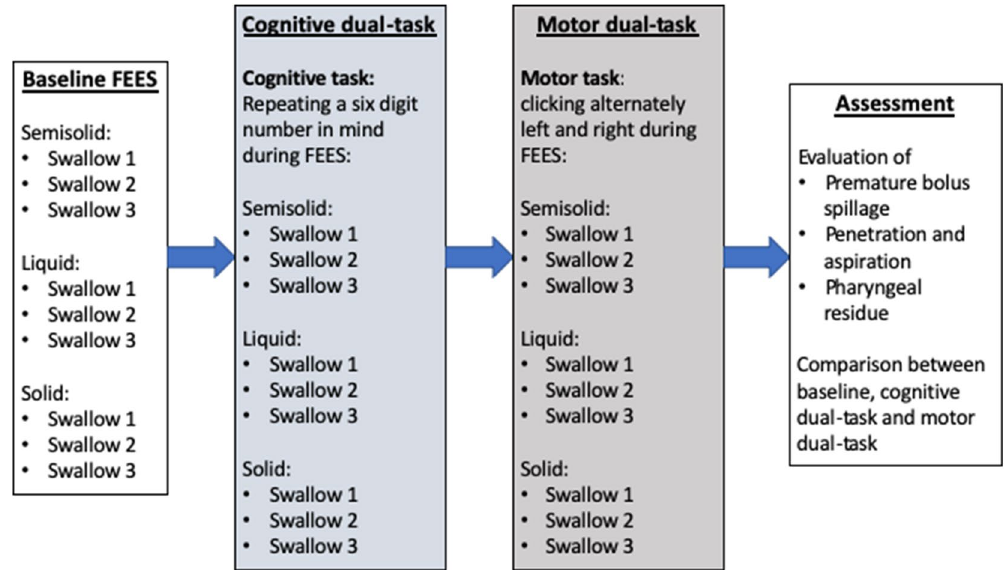
Figure 1. illustration of the study protocol. Cognitive- and motor dual-task were applied in random